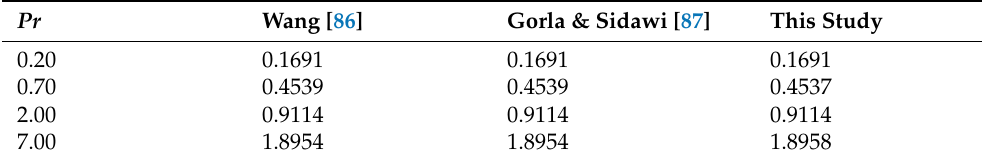
Table 3. Comparing −𝜃 (cid:4593) (0) with alteration in Prandtl number, and taking 𝜙 = 0 , 𝜗